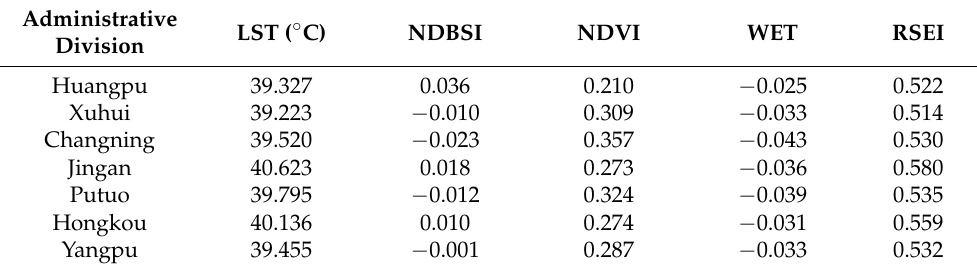
Table 1. Mean of the four indicators in the research area.